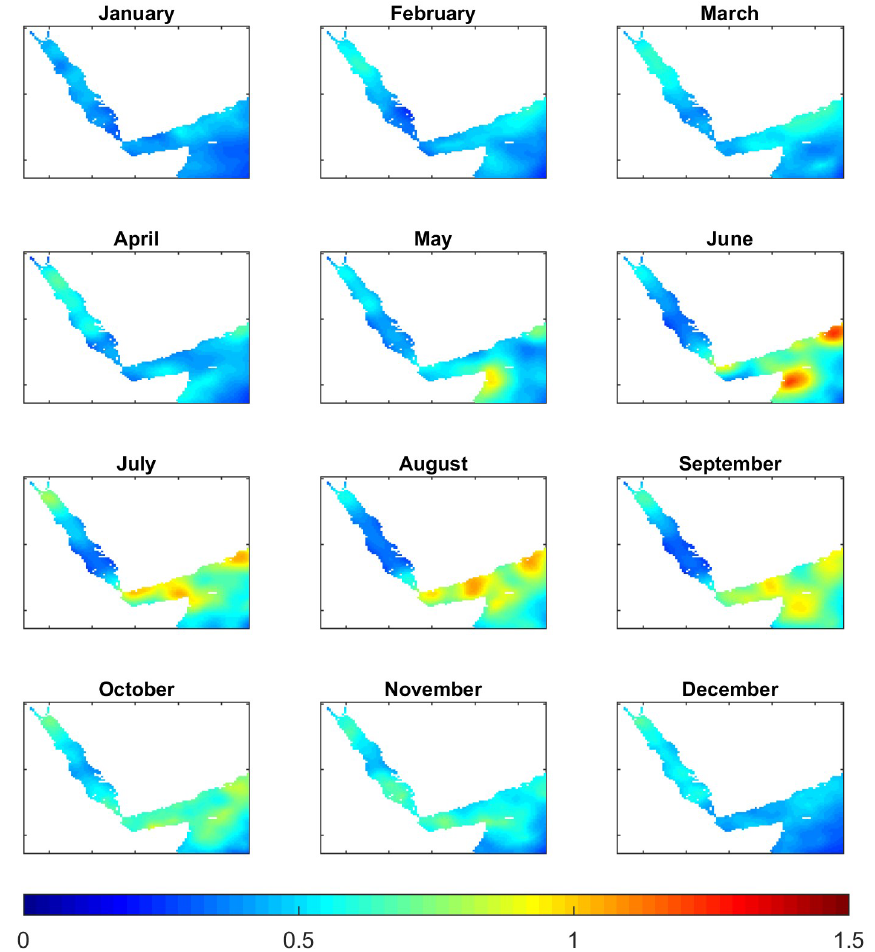
Figure 17. SD of the interannual variations of surface temperature per month (in ◦